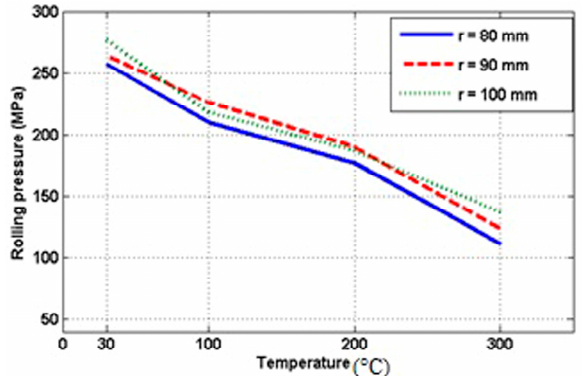
Figure 7. Maximum stress exerted on the bimetal strips with 30% of thickness reduction ratio at different roll diameters and rolling temperatures.